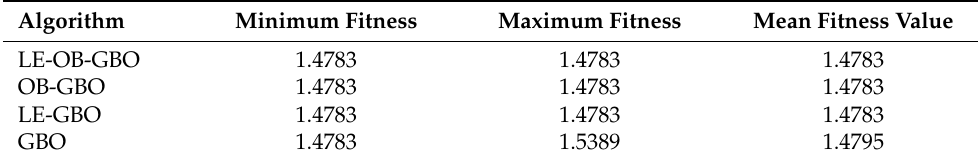
Table 9. Statistical analysis for charging station placement—case 2.